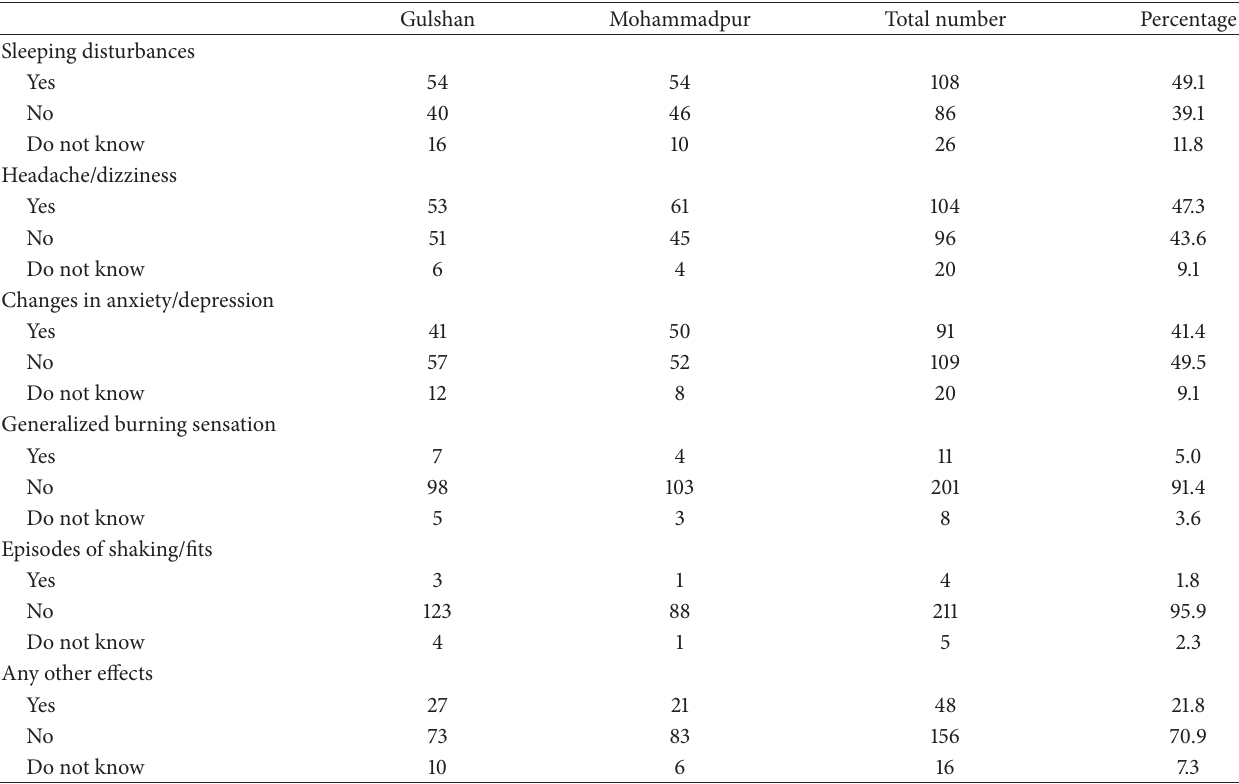
Table 3: Self-reported health problems by area of living.